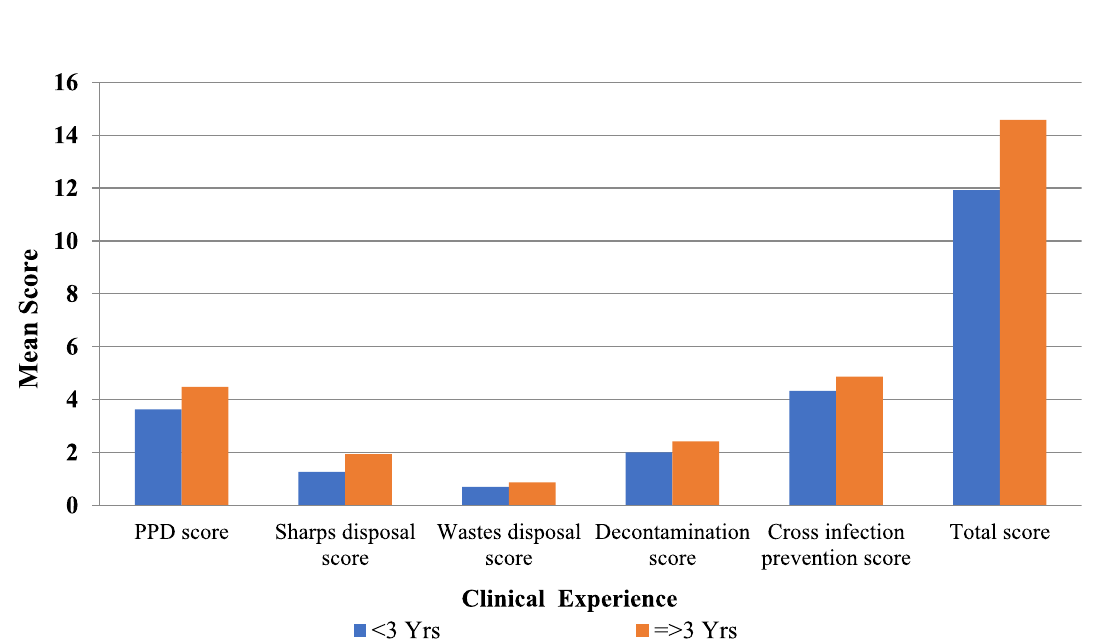
Fig. 2 Comparison of CSPS dimension scores and total CSPS score between participants regarding their clinical experience years. PPD: Personal protective